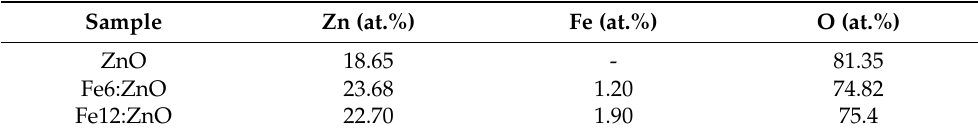
Table 1. Energy-dispersive spectroscopy (EDS) results of Fe:ZnO nanoparticles. Here, only the results related to the Zn, Fe and O elements are